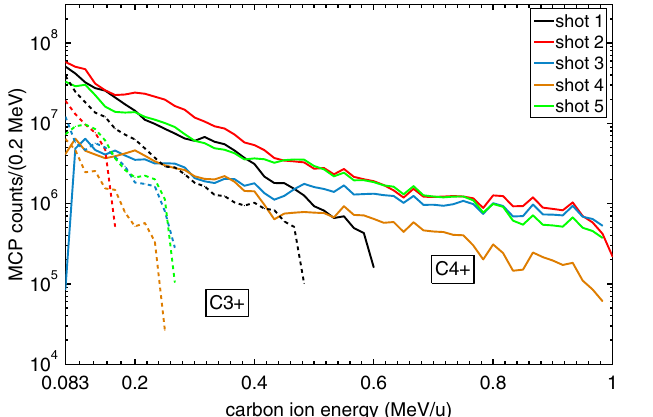
FIG. 4. Fraction of the C 4 þ , C 3 þ , and C 2 þ ion yields to the total carbon ion yield of each shot, integrated from 0.083 to 1 MeV = u . The black stars show the total carbon ion yield ratio of the individual shots with desorption to the reference shot (shot